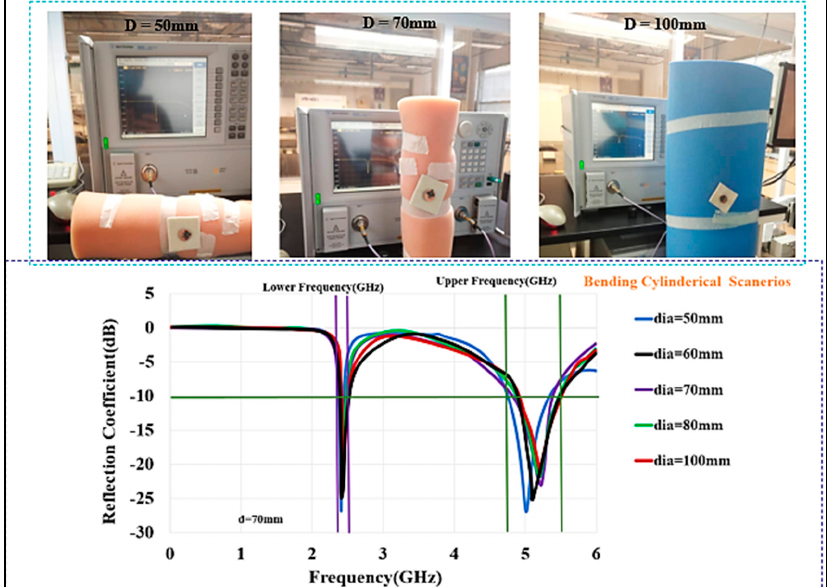
Figure 20. Measured S 11 of the BSA under bending with different cylindrical curvatures (D ( dia, in mm ) : 50, 60, 70, 80, and 100).